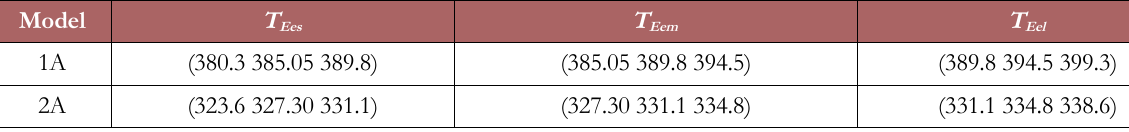
Table 19. Values of the linguistic labels for T